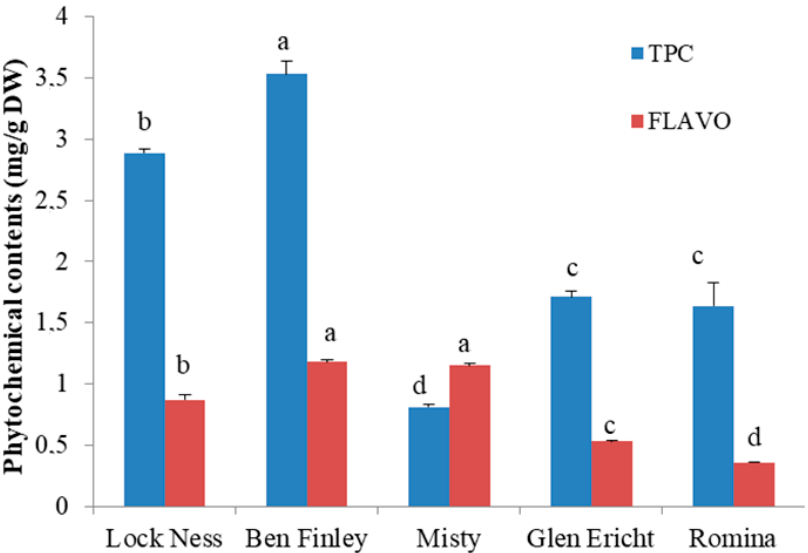
Figure 1. Phytochemical composition of the berry “IN” fractions selected for the in vitro study. Data are expressed as mean ± SD. Columns labeled with different letters are significantly different ( p < 0.05). Abbreviations: TPC, total phenolic content; Flavo, total flavonoid content; DW, digested weight.